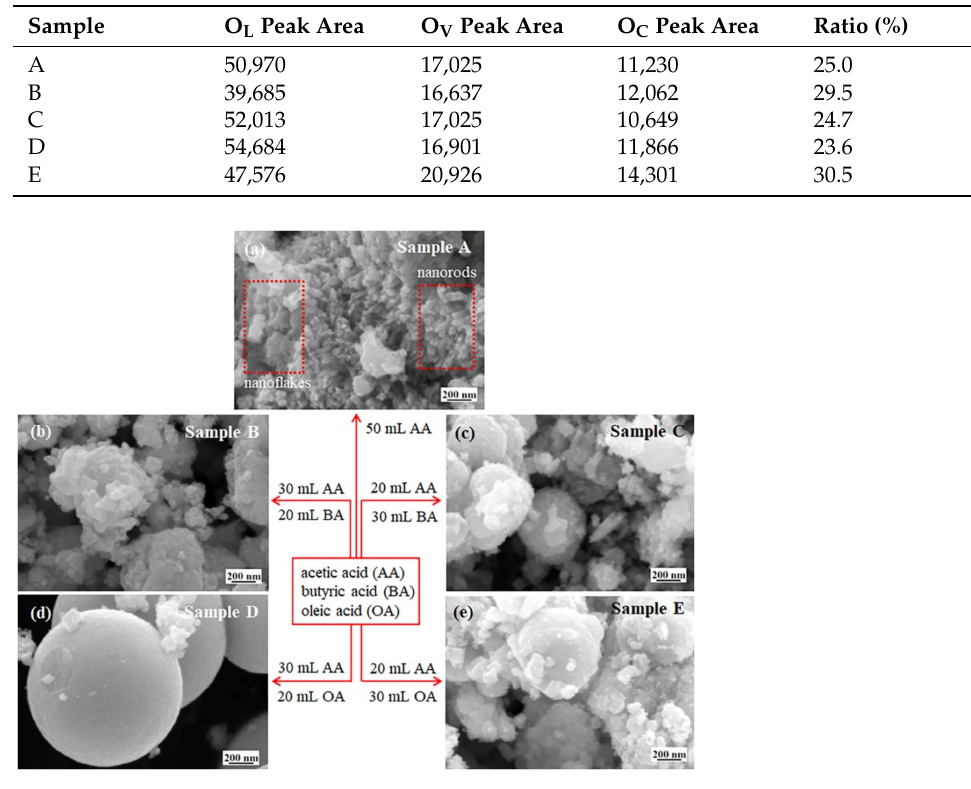
Figure 5. FESEM images of samples A − E. These images indicate that the as-synthesized WO 3- x materials are the mixture of ( a ) nanoflakes and aggregated nanodots, ( b , e ) the submicro-spherical-like, ( c ) submicro-spherical and ( d ) micro-spherical structures mixed with the aggregated